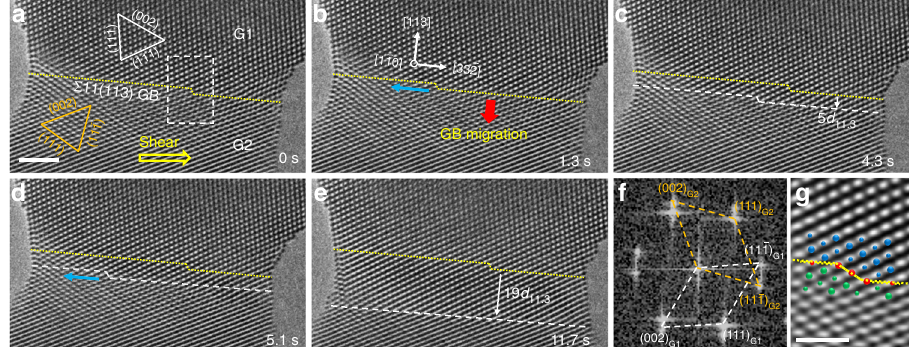
Fig. 1 Shear-induced migration of a Σ 11(113) coherent grain boundary (GB) in an Au bicrystal. a Structure of an as-fabricated Au bicrystal with a Σ 11(113) coherent GB. The lattices of the upper and bottom grains in this bicrystal showed a symmetrical relation. Close observation shows that a disconnection pre- existed on the GB. A shear stress was then applied to the bottom grain (G2) with an inclination of ~5° to the GB plane, as indicated with the yellow arrow. b GB migration mediated by the lateral motion of GB disconnection along the direction of the upper grain. The directions of GB migration and disconnection motion are indicated by the red and blue arrows, respectively. c , d Sequential deformation snapshots showing the disconnection-coupled GB migration under shear loading. e Successive migration of the GB with a total distance of 19 d 113 . The yellow dotted lines and white dashed lines in ( c – e ) represent the initial and current positions of the GB, respectively. f Fast Fourier transform pattern con fi rms the coherent relation across the GB in ( a ). g Filtered high resolution image showing the detailed structure of the disconnection core. The schematic superimposed on ( g ) presents the atomic structure of the GB disconnection. Large and small particles represent the atoms located on the neighbouring planes. Scale bars: ( a ) 2 nm, ( g ) 1